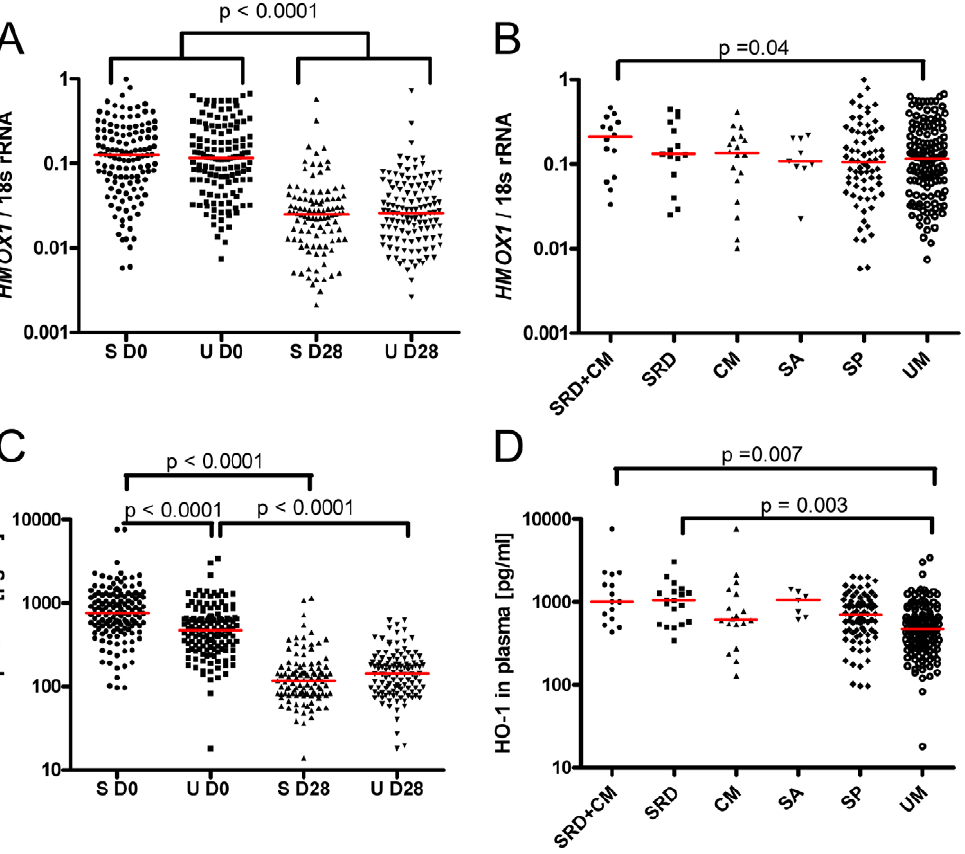
Figure 2. HMOX1 mRNA and HO-1 protein are upregulated in acute malaria, being highest in cases with SRD. HMOX1 mRNA levels measured in whole blood are shown comparing A) severe (n=128) and uncomplicated (n=134) cases over time, and B) different disease entities on day 0. HO-1 plasma concentrations are shown comparing C) severe (n=138) and uncomplicated (n=137) cases over time, and D) different disease entities on day 0. P values shown in A) and C) are derived from the random effects regression model, adjusting for age, gender, duration of symptoms and neutrophil counts. P values shown in B) and D) are from a linear regression model adjusting for age, gender, duration of symptoms, neutrophil counts and Hb. S=severe, U=uncomplicated, D0=day 0, D28=day 28. SRD=severe respiratory distress, CM=cerebral malaria, SA=severe anaemia, SP=severe prostration, UM=uncomplicated malaria. The red lines represent the medians.